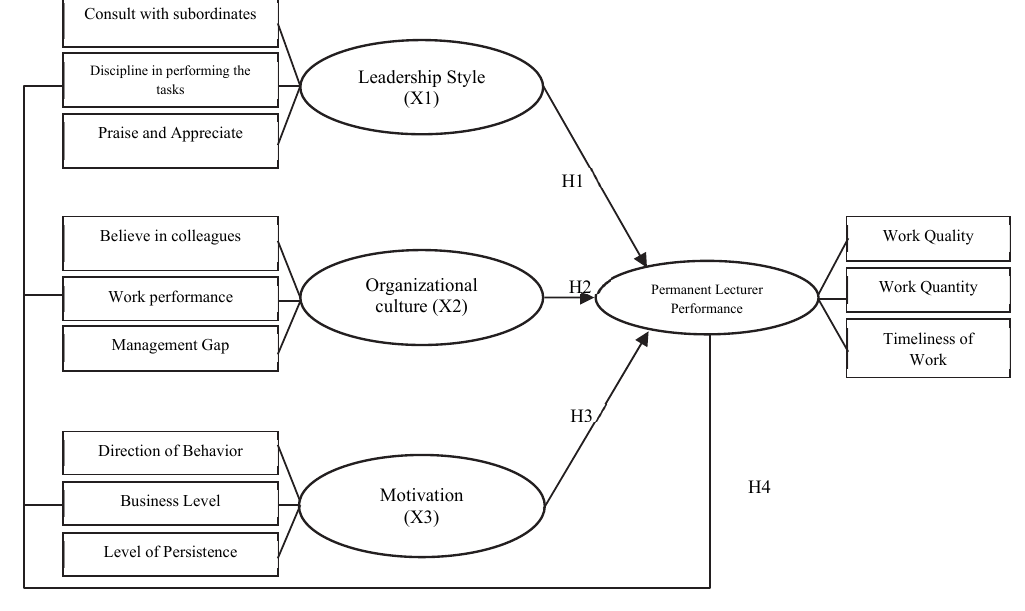
Fig. 1. The proposed